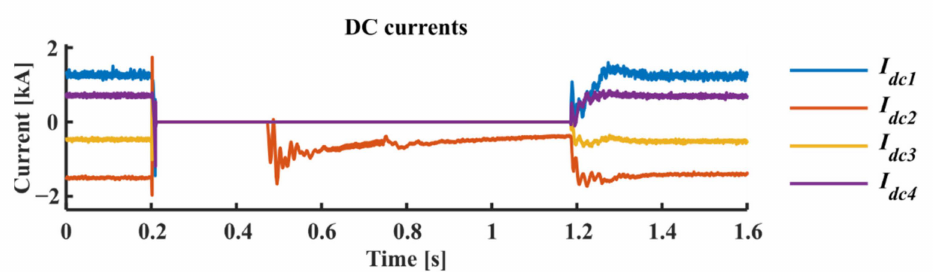
Figure 17. DC currents of the MTDC terminals with DC fault at location F2.